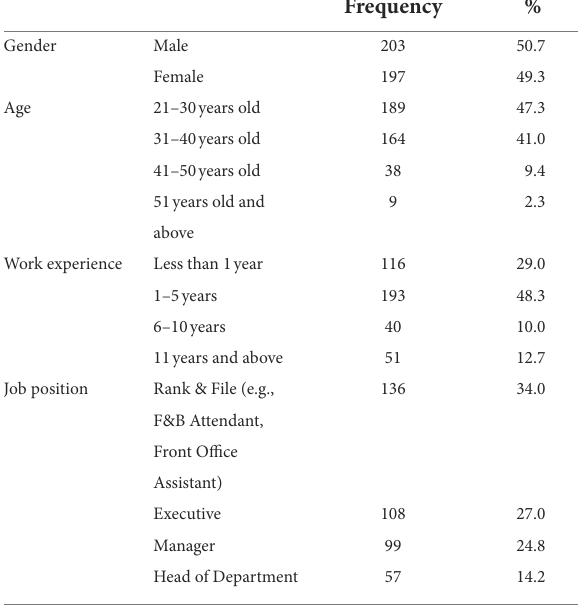
TABLE 1 Demographic profile of